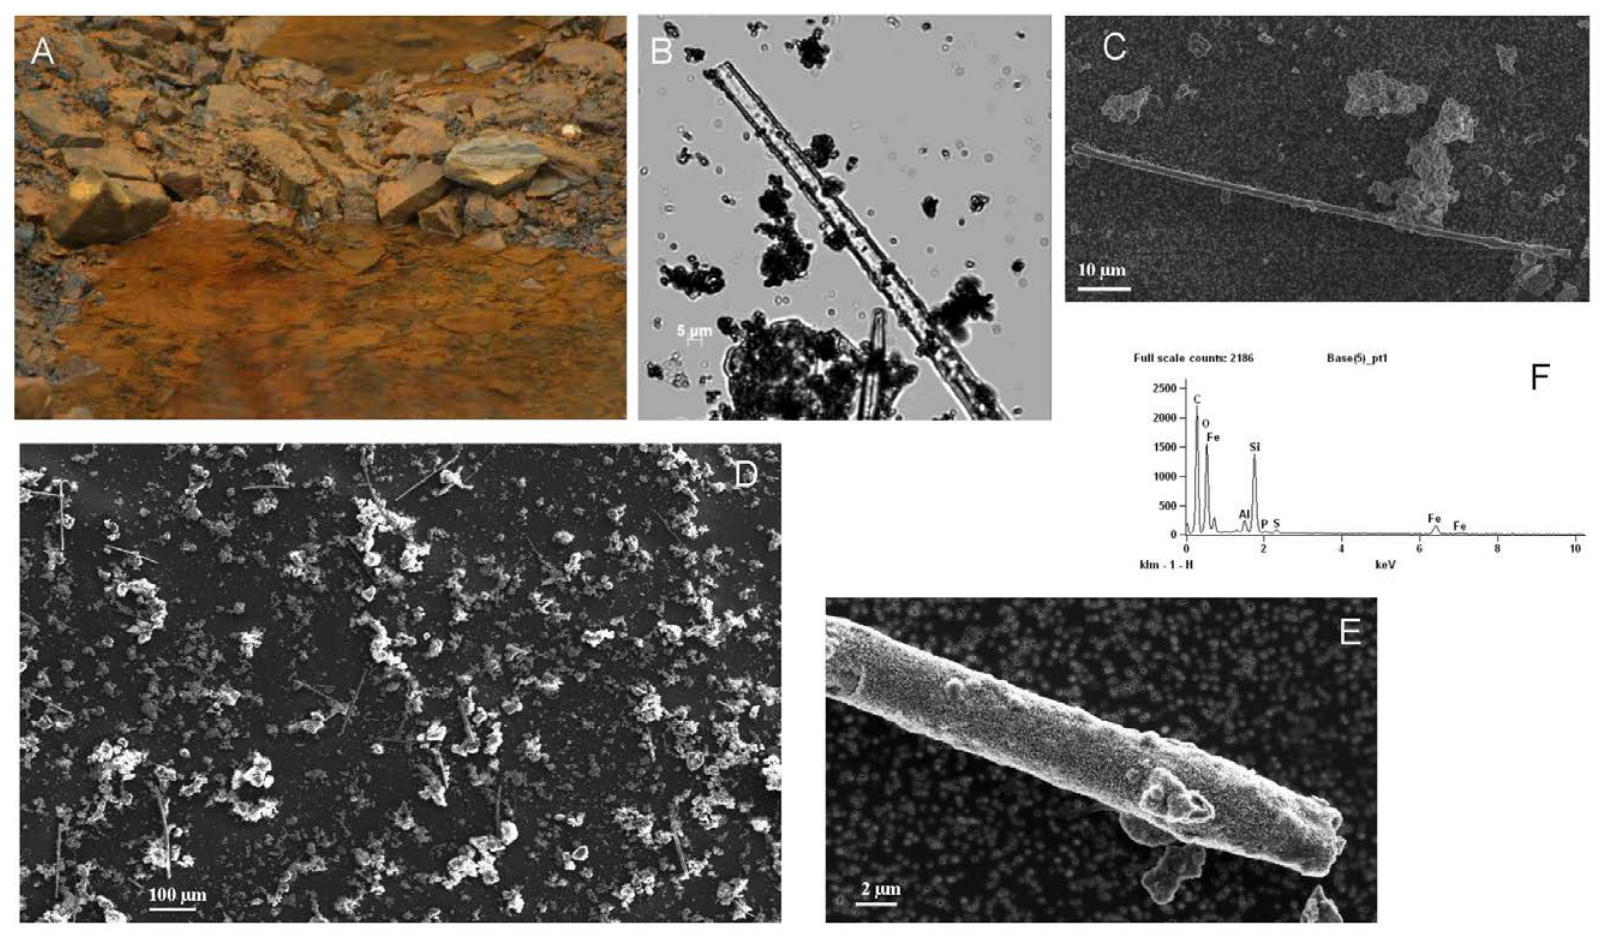
Figure A5. ( A ) Close up picture of the ochre mineral coat at Bjørndalen. ( B ) Phase contrast light micrograph showing iron stalks. ( C , D ) Scanning electron micrographs of iron stalks. ( E ) Energy dispersive X-ray spectroscopy (EDS) coupled to scanning electron microscopy from an iron